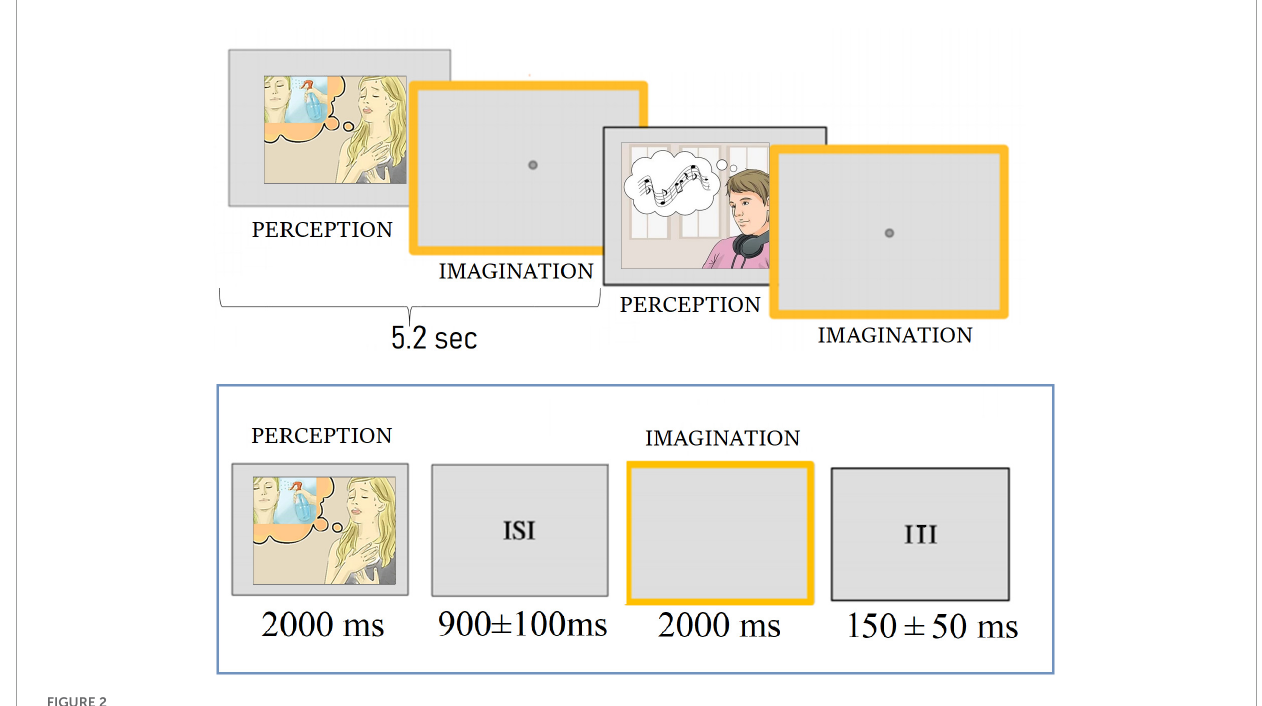
FIGURE2 Time sketch of the experimental